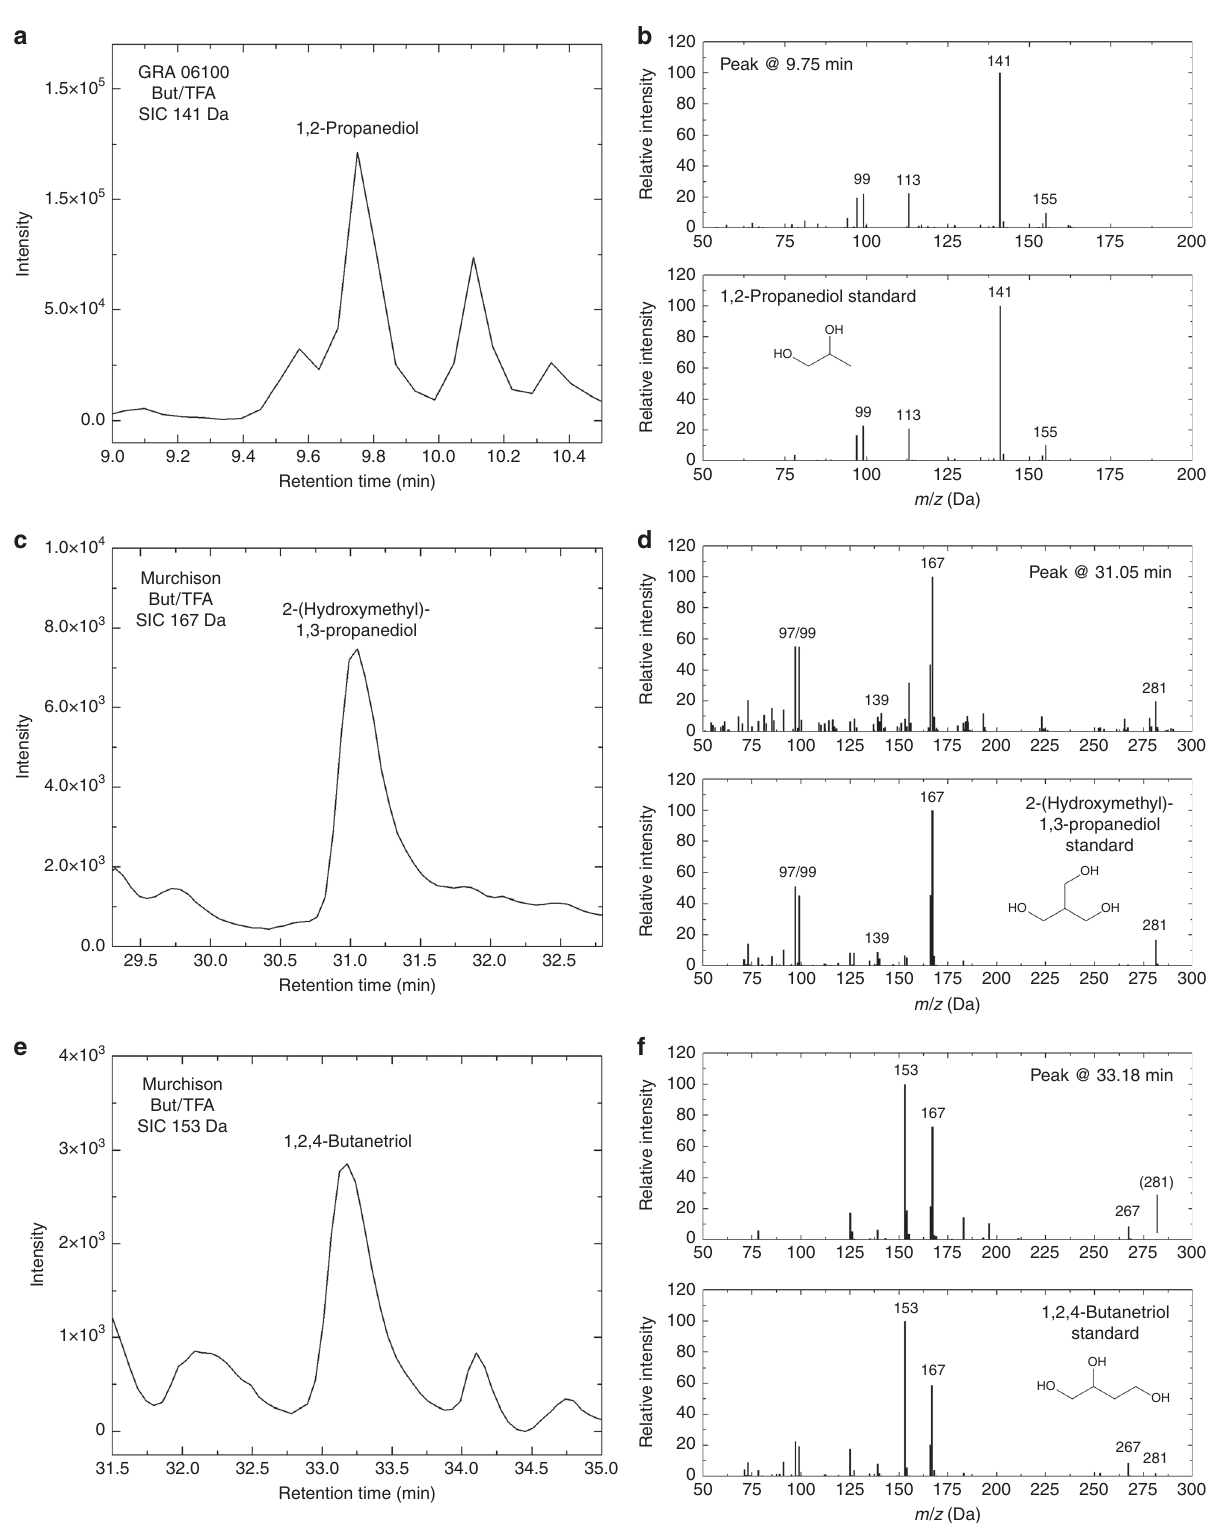
Fig. 4 Identi fi cation of three deoxysugar alcohols in meteorites. a Single-ion chromatogram (SIC) of a sample from GRA 06100 ( m / z = 141 Da) derivatized with ( + )-2-butanol/TFAA. b Mass spectrum of the peak assigned to 1,2-propanediol, compared with the mass spectrum of a standard of 1,2-propanediol. c SIC of a sample from Murchison (167 Da) derivatized with ( + )-2-butanol/TFAA. d Mass spectrum of the peak assigned to 2-(hydroxymethyl)-1,3- propanediol, compared with the mass spectrum of a standard of 2-(hydroxymethyl)-1,3-propanediol. e SIC of the same Murchison sample (153 Da). f Mass spectrum of the peak assigned to 1,2,4-butanetriol, compared with the mass spectrum of a standard of 1,2,4-butanetriol. Deoxysugar alcohols only accept TFAA derivatization under the present conditions, i.e., only O – TFA bonds are formed. Molecular structures are shown without derivatization. Assignments of the fragments in the mass spectra can be found in Supplementary Table